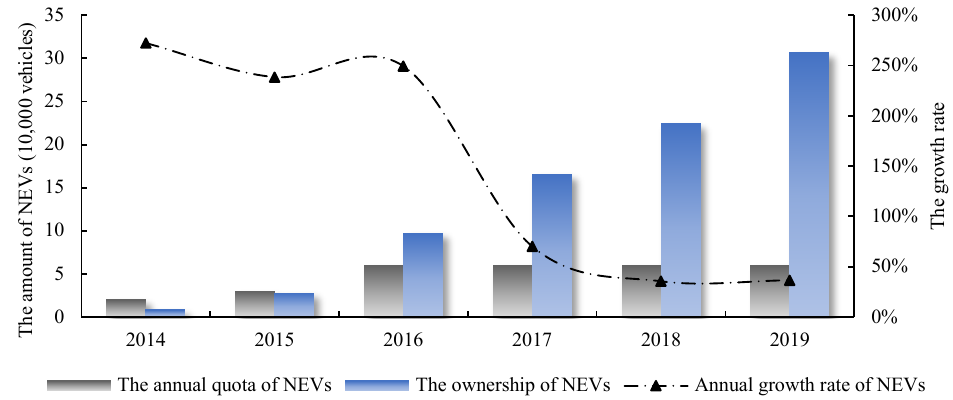
Figure 1. Quota, ownership and growth rate of NEVs in Beijing from 2014 to 2019.